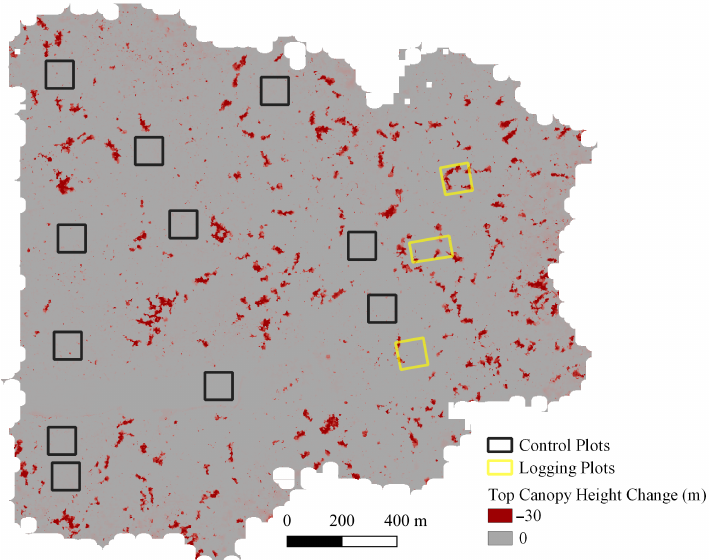
Figure 2. Top canopy height change from January 2020 to January 2021 measured using UAV LiDAR (background image), showing decreases in three logged plots (yellow rectangles) and no major changes inside our control plots (black squares). Note that most of the disturbances in the area occurred after the post-logging TDX acquisitions in February 2020.